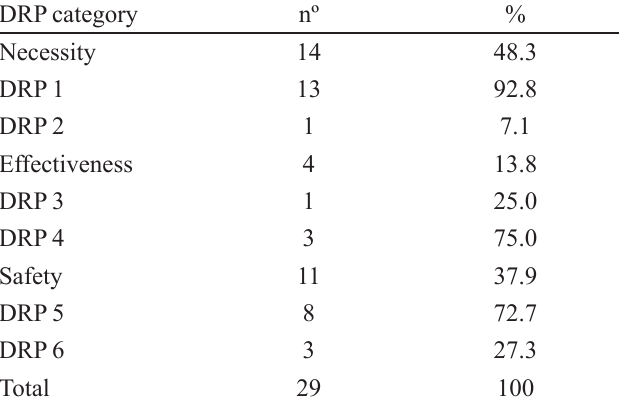
TABLE III - Distribution of patients carrying human immuno- deficiency virus (HIV) according to access to prevention strategies against vertical transmission (n=27) (DHGMM, 2007) Variables Realization of anti-HIV test in the prenatal phase